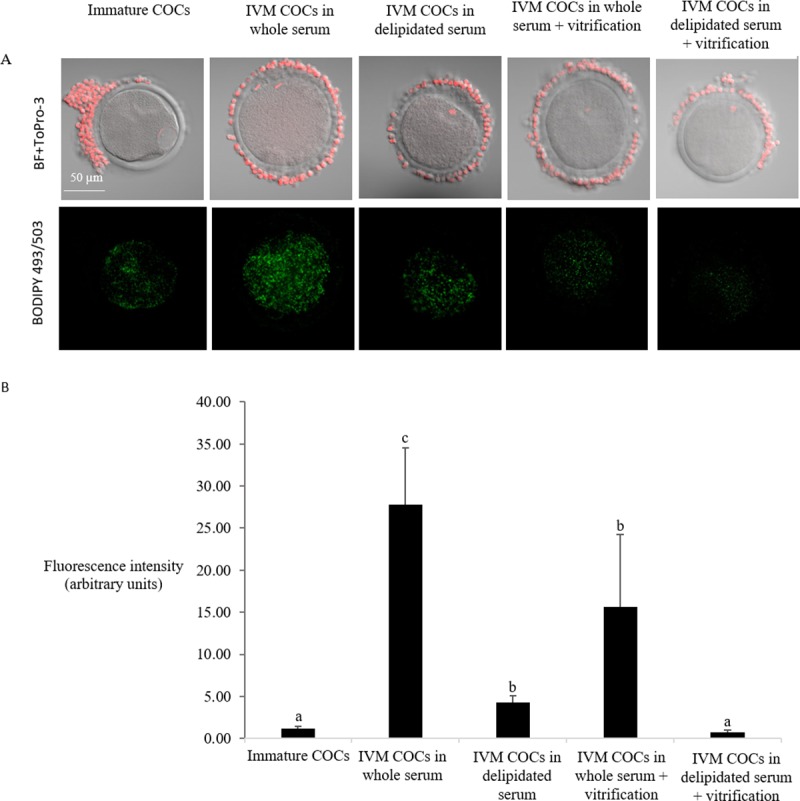
Effect of vitrification on lipid droplet content of partially denuded COCs after IVM under different lipid content conditions (Experiment 2).a) Nuclei of cells were stained with ToPro-3 (red) and merged with bright field image (BF). Neutral Lipid staining with BODIPY 493/503 (green) shows a decrease in lipid droplets of oocytes after vitrification. b) Comparison of the lipid content of immature (Immature, n = 12) versus IVM COCs in a medium supplemented with control whole (n = 16) or delipidated estrous sheep serum (n = 19) before or after vitrification (control whole serum+ vitrification group, n = 12; Delipidated serum+ vitrification n = 11). Values are expressed as average of BODIPY fluorescence intensity in the ooplasma per area ± SEM. Different superscripts indicate significant differences (P< 0.05).